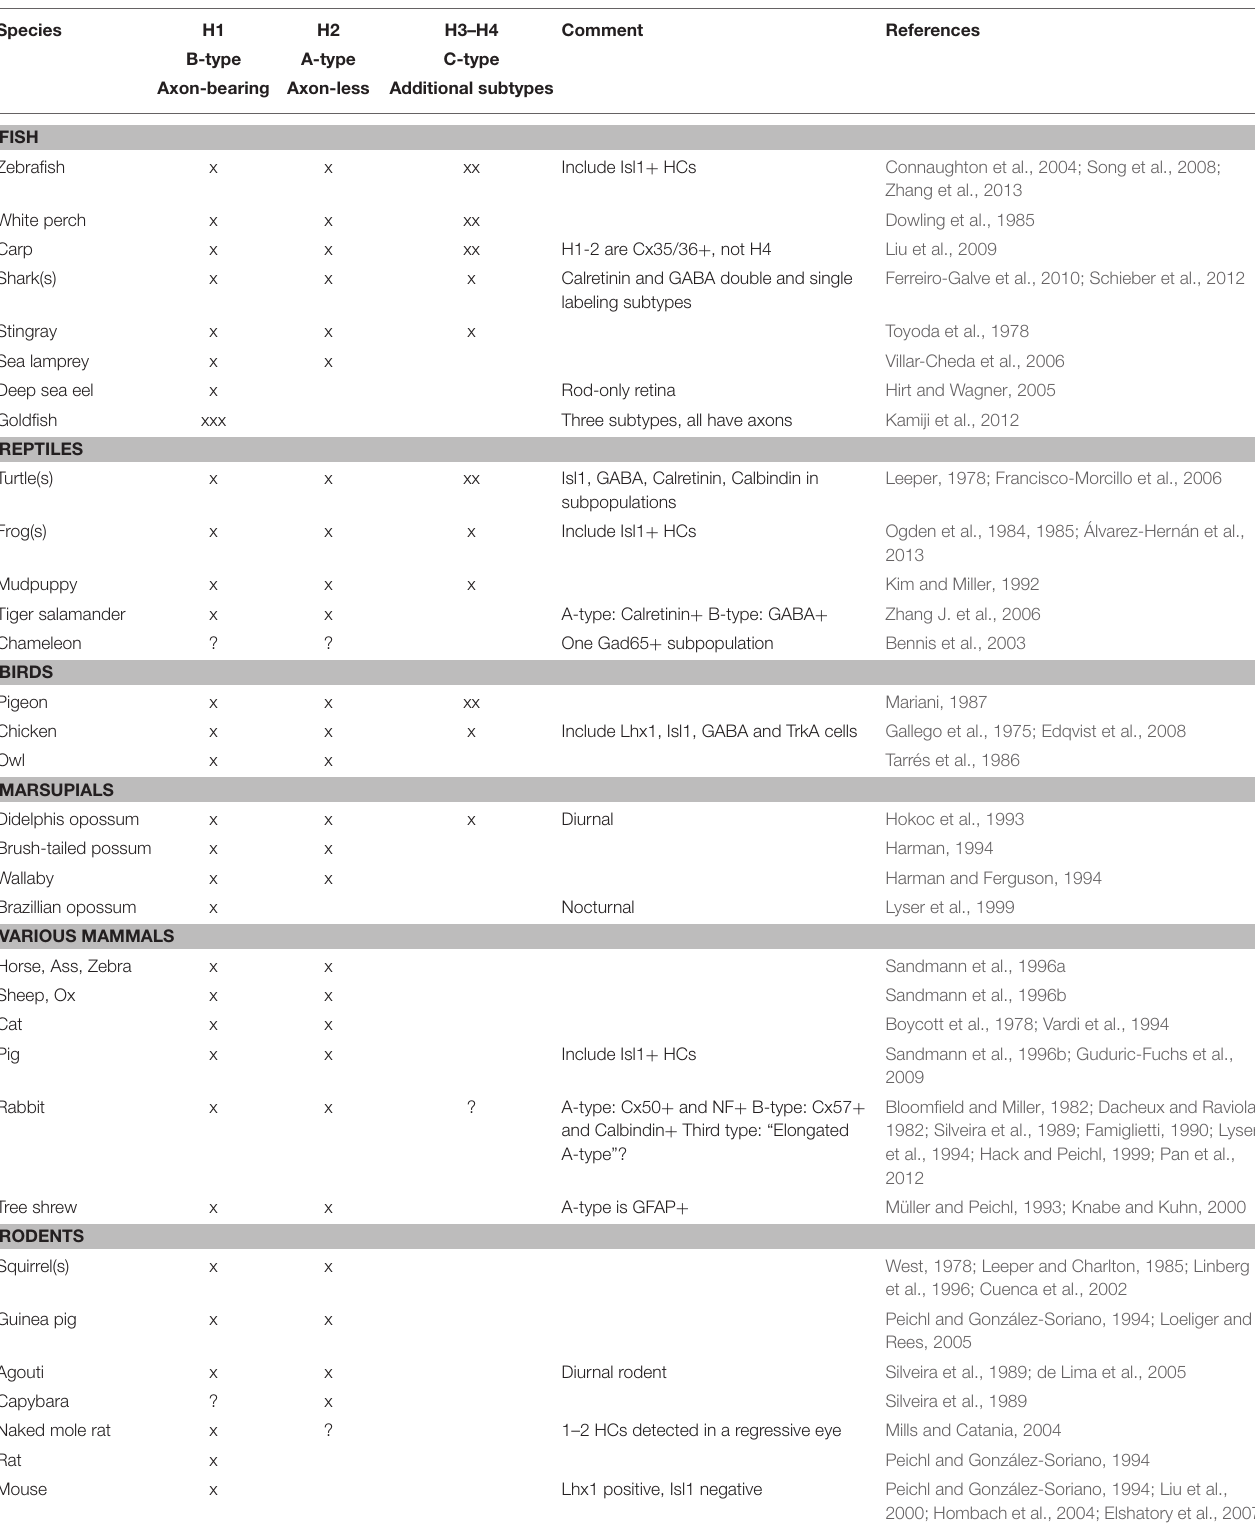
TABLE 1 | Species comparison of horizontal cell